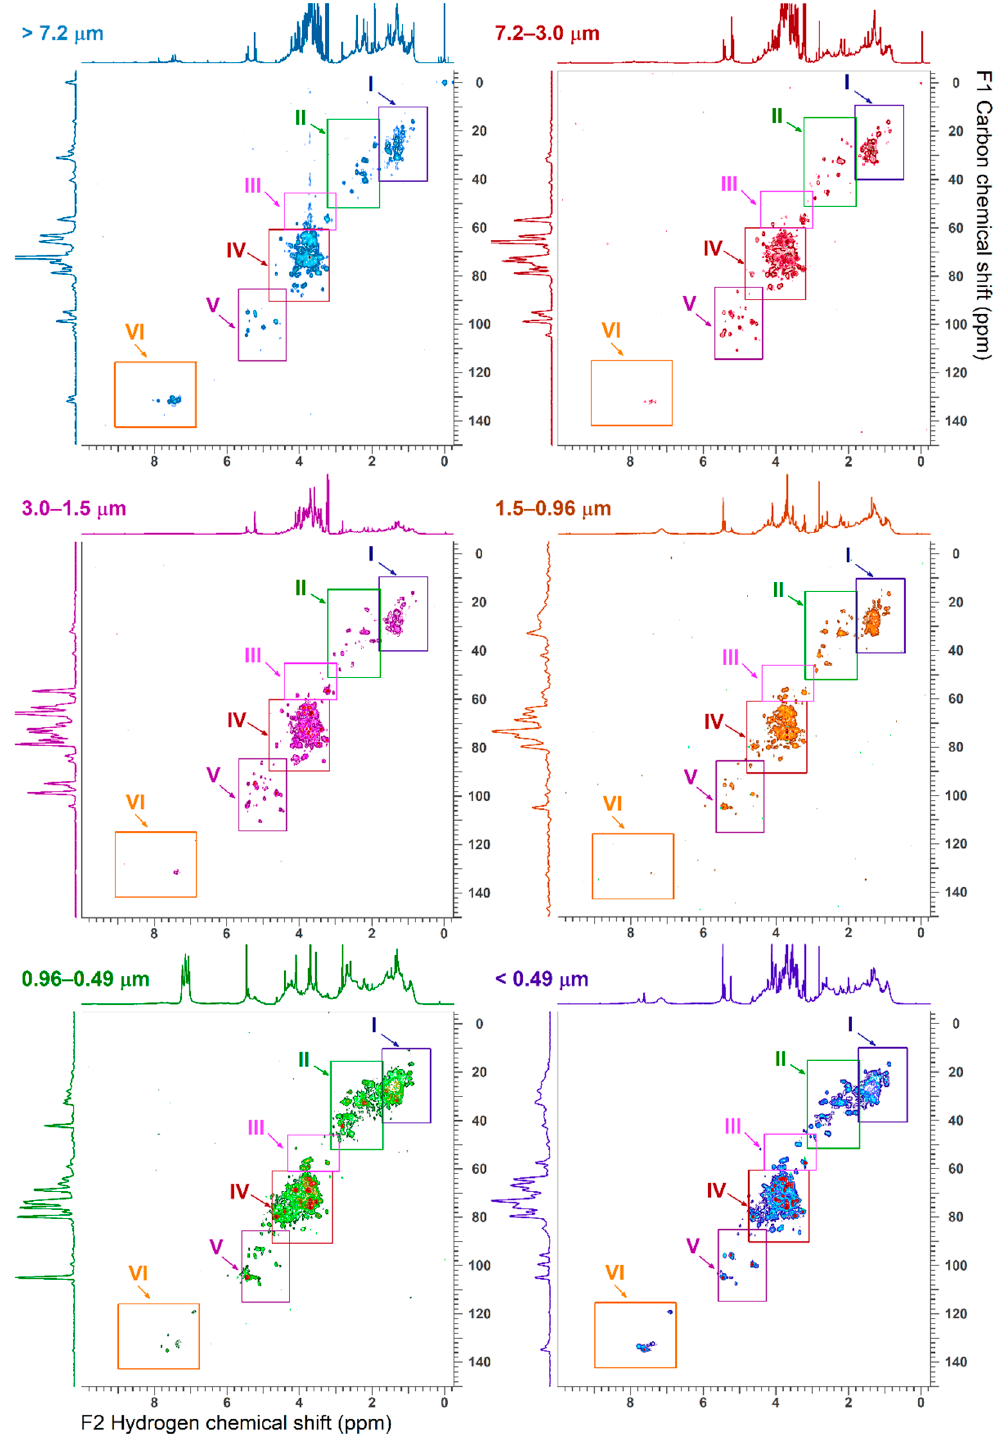
Figure 6. 1 H- 13 C HSQC NMR spectra of size fractionated water-soluble organic carbon. The regions I and II are detailed in Figure S3, region III, IV and V in Figure S6, region VI in Figure S9. The x-axis F2 represents the hydrogen frequencies (in ppm) and the y-axis F1 represents the carbon frequencies (in ppm).